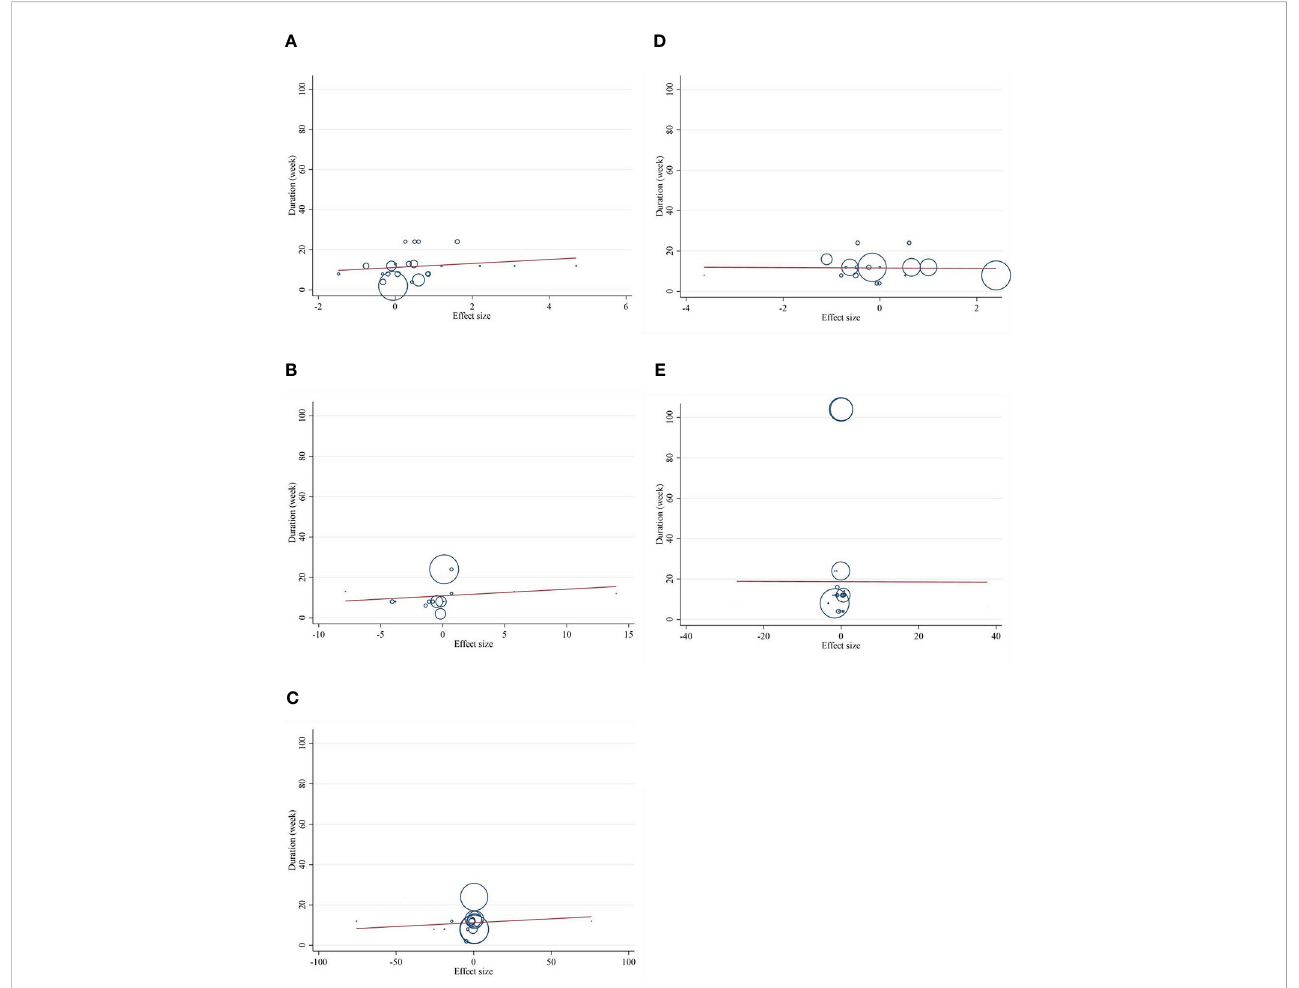
FIGURE 7 Random-effects meta-regression plots of the association between duration of intervention of CLA and weighted mean difference of (A) CRP (mg/L), (B) IL-6 (pg/ml), (C) TNF- a (ng/ml), (D) adiponectin (µg/ml), and (E) leptin (ng/ml). Horizontal lines represent 95% CIs. Diamonds represent pooled estimates from random-effects analysis. WMD, weighted mean difference; CI, con fi dence interval; CRP, C-reactive protein; IL-6, interleukin 6; TNF- a , tumor necrosis factor-alpha.